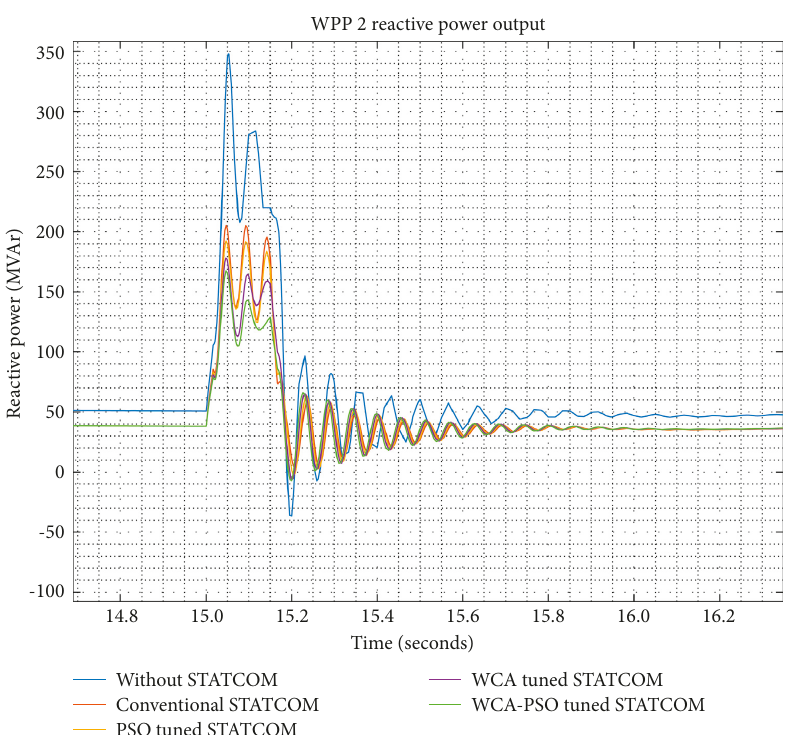
Figure 24: WPP 2 reactive power